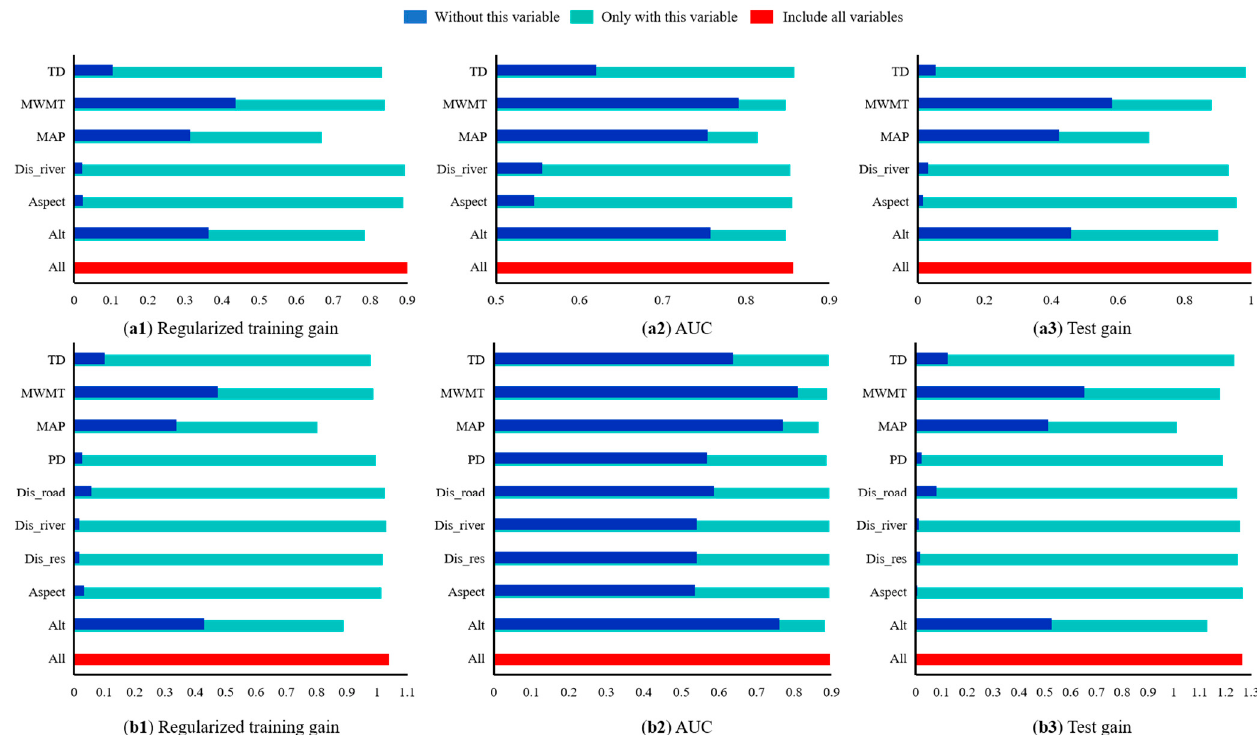
Figure 4. Results of the jackknife test to obtain the important values of the environmental factors influencing the distribution of Asian elephants in Sipsongpanna for ( a1 – a3 ) non-anthropogenic interference (NAI) and ( b1 – b3 ) anthropogenic interference (AI). The environmental variables and their abbreviations are listed in Table